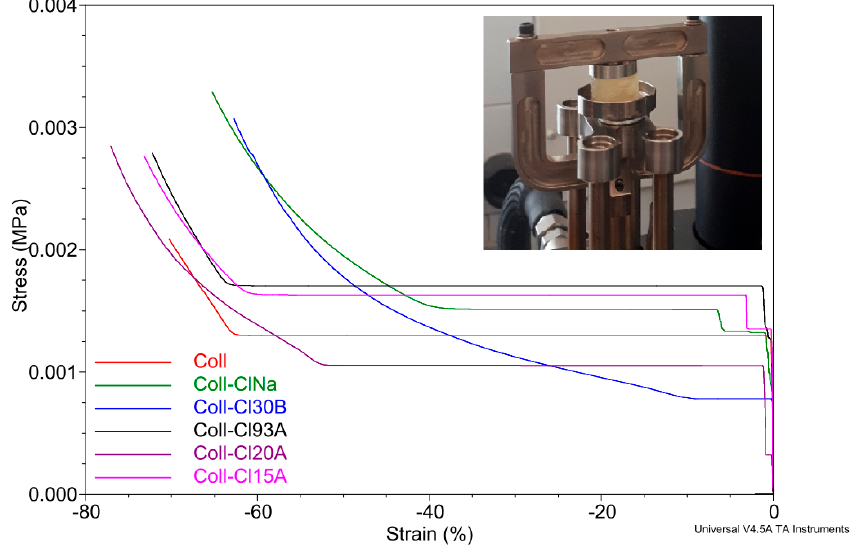
Figure 8. DMA stress – strain curves for the collagen/clay composite hydrogels swollen in